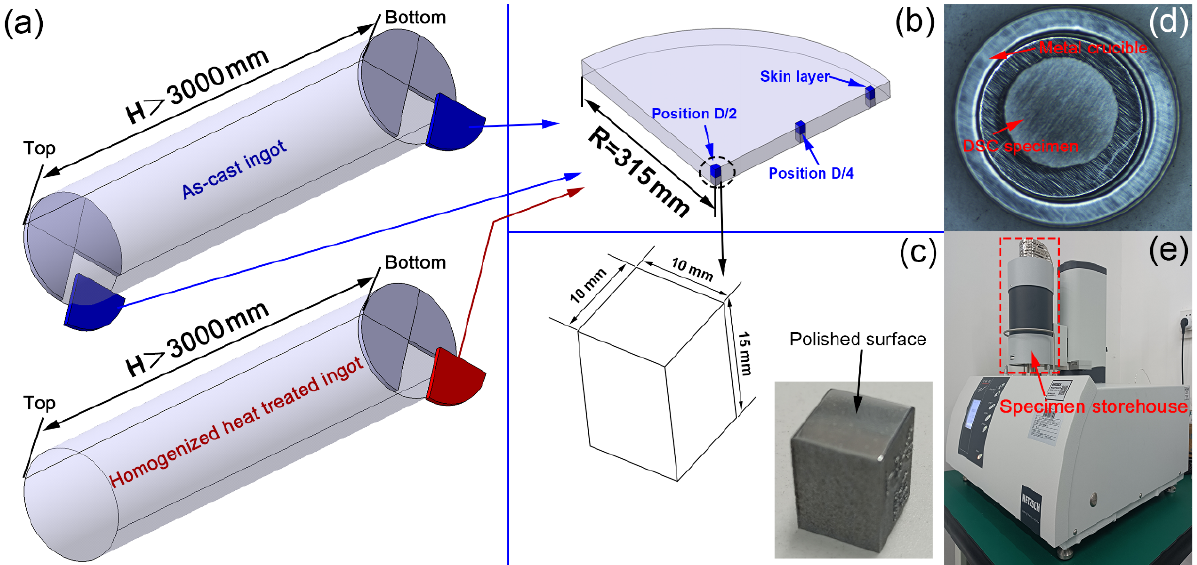
Figure 1. Schematic of the large-scale Al-Cu-Mg-Ag alloy ingots ( a ), sawed ingot slice ( b ), metallo- graphic specimen ( c ), DSC sample ( d ), and the NETZSCH DSC 404 F3 equipment ( e ). Table 1. Results of the chemical composition analysis of the different typical positions in the ingot. Element Type Positions NO.